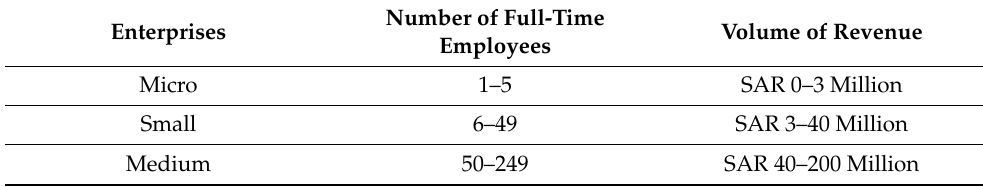
Table 1. Categorization of SMEs as defined by Monshaat in Saudi